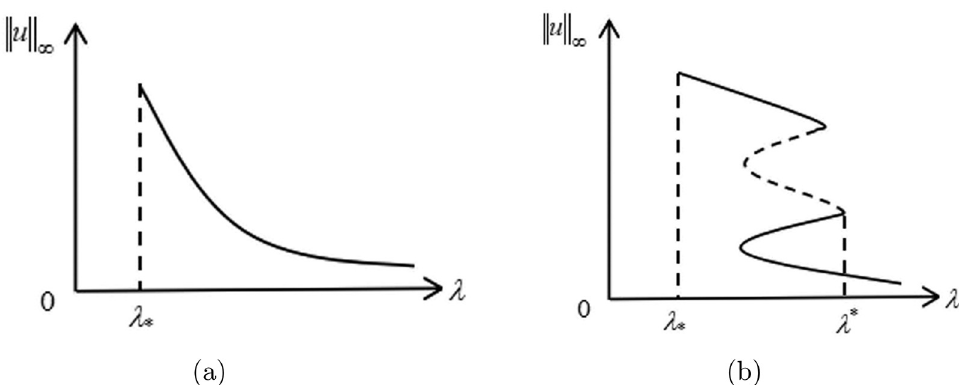
( ) ( ) 2 , 0 π with = p 1 . ( a ) > λ 1 , < < L 0 L 2